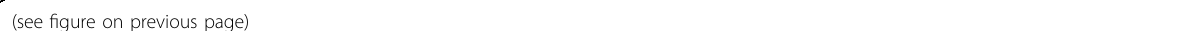
Fig. 4 Genetic and pharmacological inhibition of BCL-X L increases autophagic fl ux in MPM cells. A , Volcano plot of Spearmans ’ rank correlation coef fi cient between BCL-X L and other tested proteins ( n = 217). Proteomic data were downloaded from TCPA, and proteins signi fi cantly (adjusted p value (or q value) <0.05) correlated with BCL-X L are highlighted. B Immunoblots of MESO-1 treated with A-1155463 for 24 h. C , D MPM cells transiently transfected with BCL2L1 -siRNAs (siBCL2L1) were treated (48 h post-transfection) with Ba fi lomycin (200 nM) or vehicle (DMSO) for 2 h before subjected to immunoblots to assess autophagic fl ux. Protein quanti fi cation is shown in ( D ). Note the increase in LC3B-II/Actin ratio by BCL2L1 knockdown in the absence and presence of Ba fi lomycin. E , F MPM cells pre-treated with A-1155463 (1 μ M) for 24 h were exposed to Ba fi lomycin (200nM) or vehicle (DMSO) for another 2 h before immunoblot analysis. Protein quanti fi cation is shown in ( F ). Note the increase in LC3B-II/Actin ratio by A-1155463 treatment in the absence and presence of Ba fi lomycin. G , H MPM cells stably expressing mCherry-eGFP-LC3B were transfected with BCL2L1 -siRNA (siBCL2L1) or control siRNA for 48 h ( G ), or treated with A-1155463 (1 μ M) or vehicle for 24 h ( H ) before analyzed by fl ow cytometry. Data were presented as mean ± s.d. ( n = 3). * p < 0.05, ** p < 0.01, and **** p < 0.0001 by two-way ANOVA with Sidak ’ s multiple comparisons test of control high versus experimental high (red). I Genetic status and mRNA/protein expression of BCL2L1 and SQSTM1 in a TCGA cohort of MPM patients ( n = 87). Data were downloaded from cBioPortal. J Kaplan – Meier analysis of MPM based on p62 protein level. TCGA cohort of MPM patients ( n = 61) with high- (in red) or low-p62 (in black) were strati fi ed by optimal cutoff value of the p62 across all patients using the surv_cutpoint function in the R “ maxstat ” package. The p value is calculated by the log-rank test using R (version